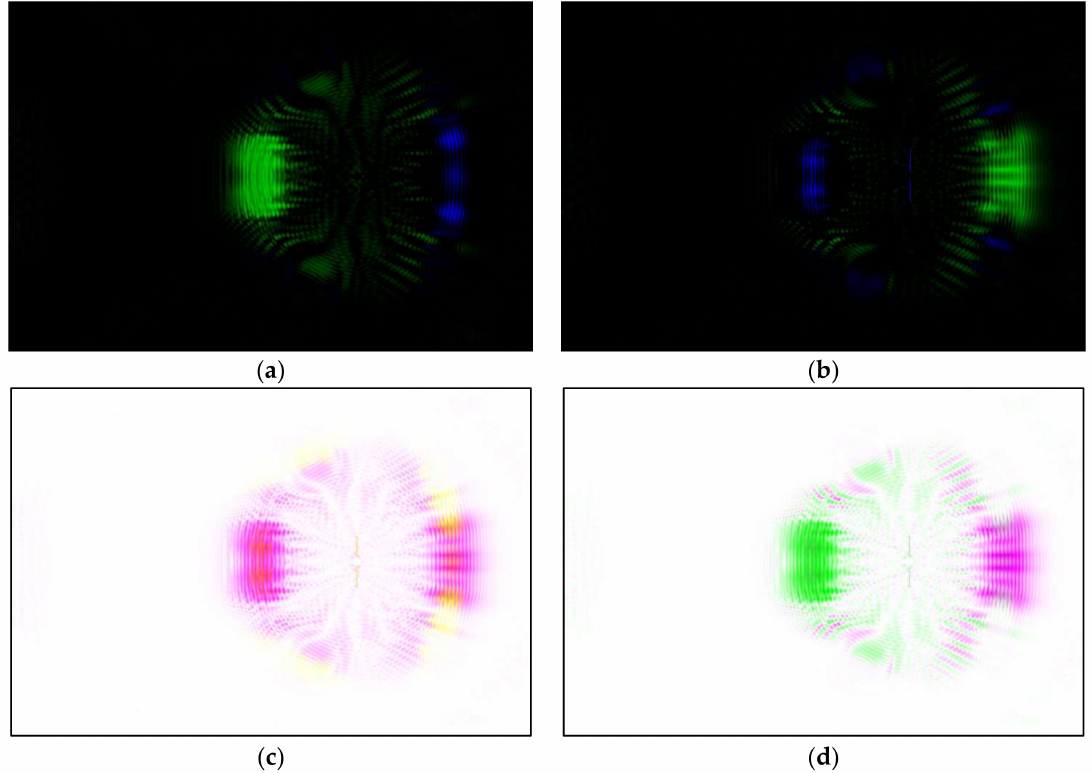
Figure 4. ( a ) Differential image of (3h − 3e); ( b ) Differential image of (3e − 3h); ( c ) Inverse of added image (4a + 4b); ( d ) Inverse of fused image (4a +